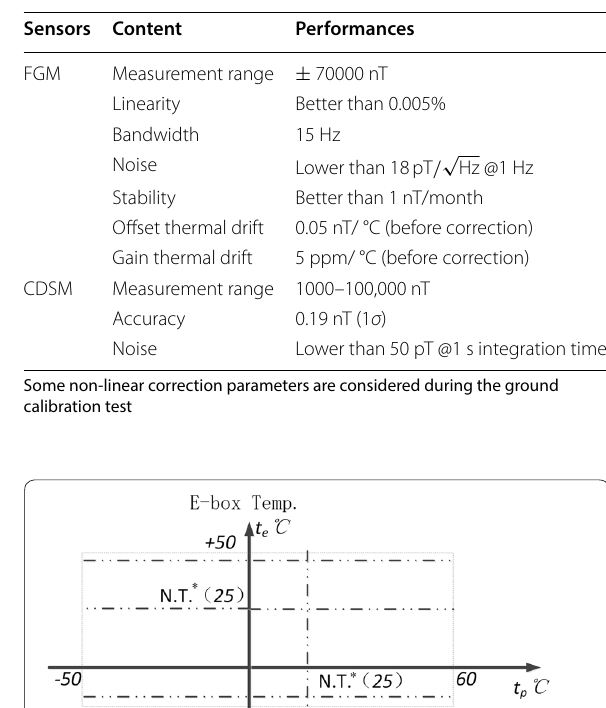
Table 1 HPM performances Sensors Content